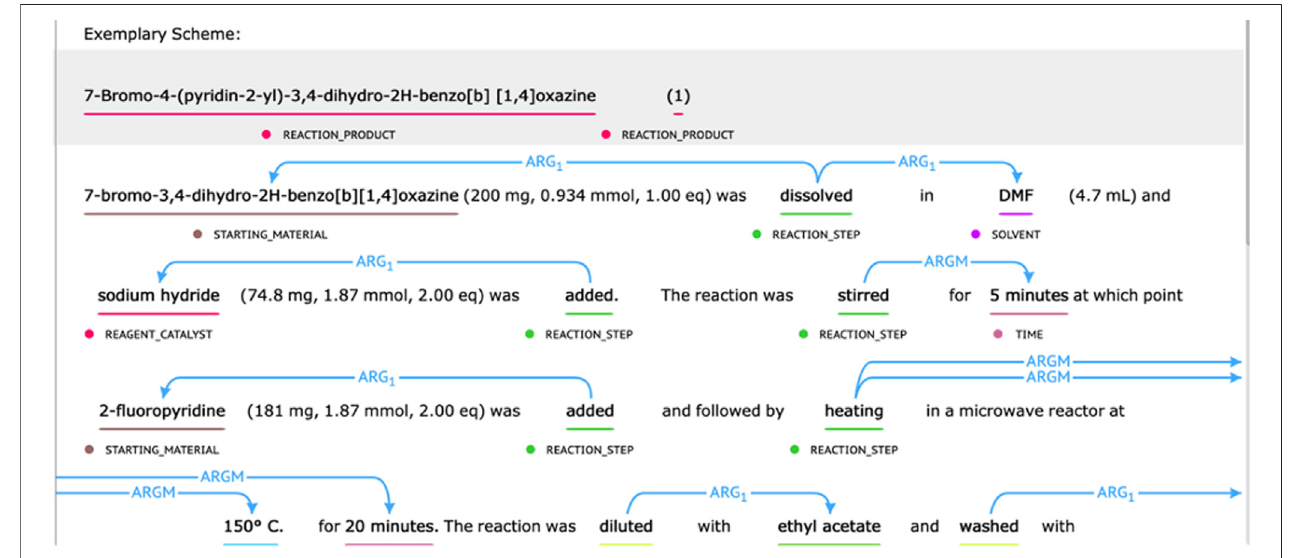
FIGURE 1 | Examples of chemical reaction elements and relations annotated in